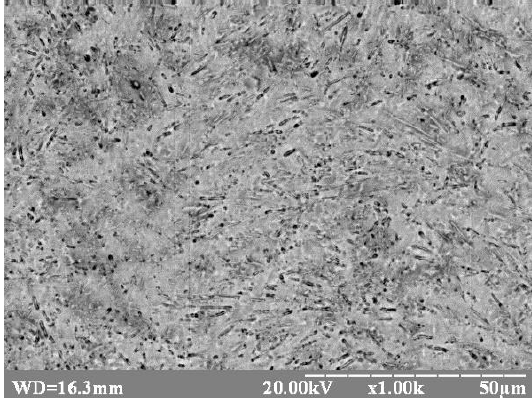
Figure 4. Typical structure of Ti-TiB alloy in the weld metal after welding.